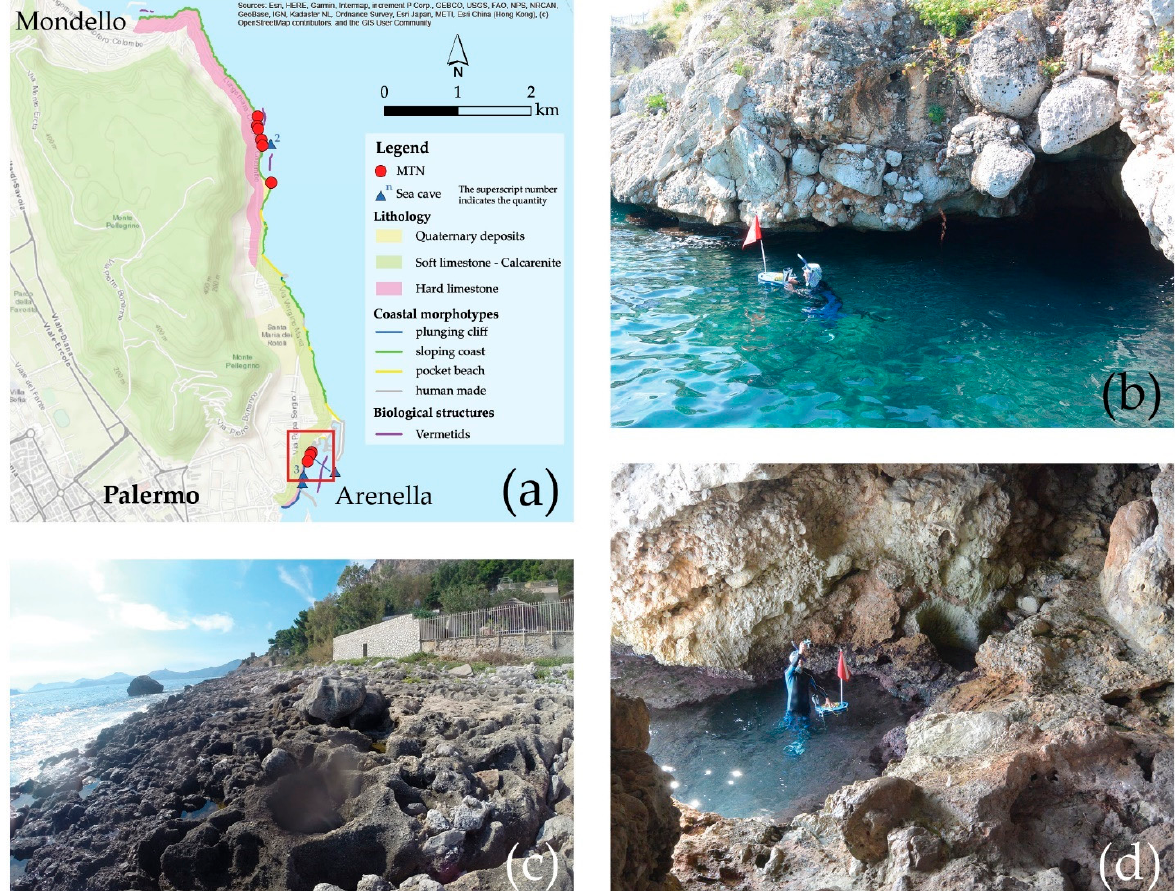
Figure 9 . ( a ) Maps of coastal morphotypes and geomorphological and biological structures on the northern coast of Palermo (Sicily, Italy). Inside the red square, one measure every 20 m of coast was carried out; ( b ) tidal notch at the entrance of a sea cave; ( c ) sloping coast; ( d ) sea cave cut in conglomerate.